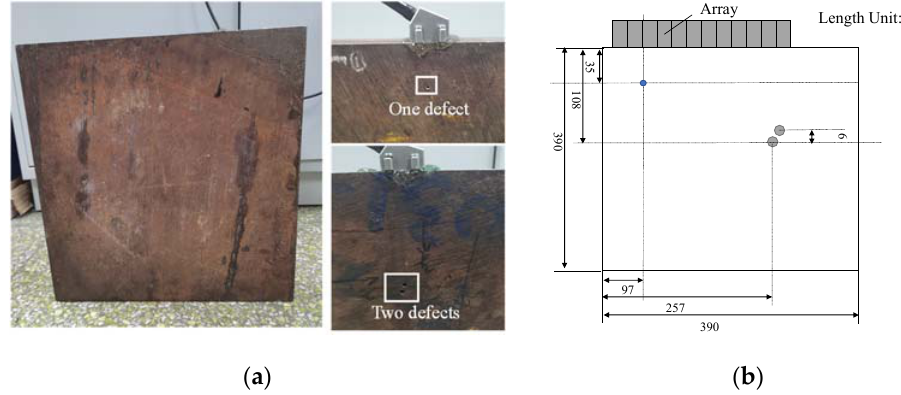
Figure 4. ( a ) Physical diagram; ( b ) schematic diagram of the experimental specimen.